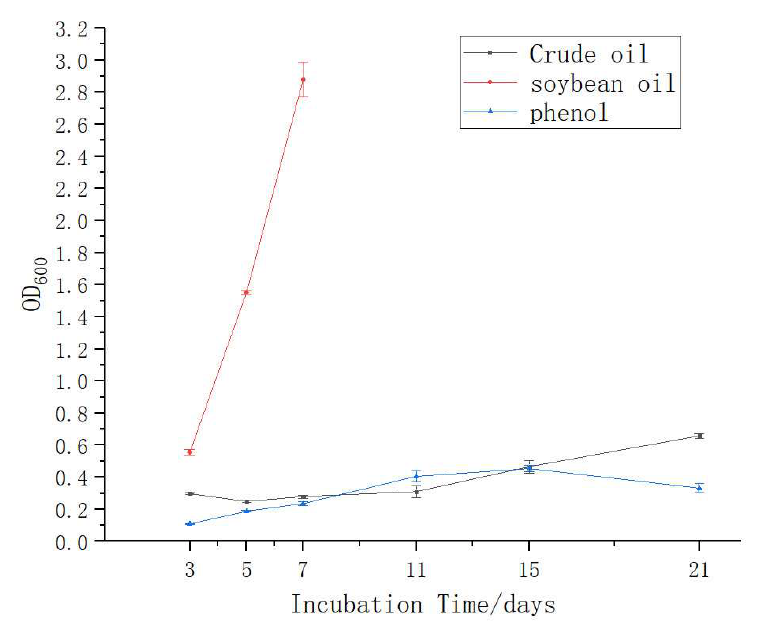
Figure 5. Growth of the H9-3 strain in different carbon sources for 21